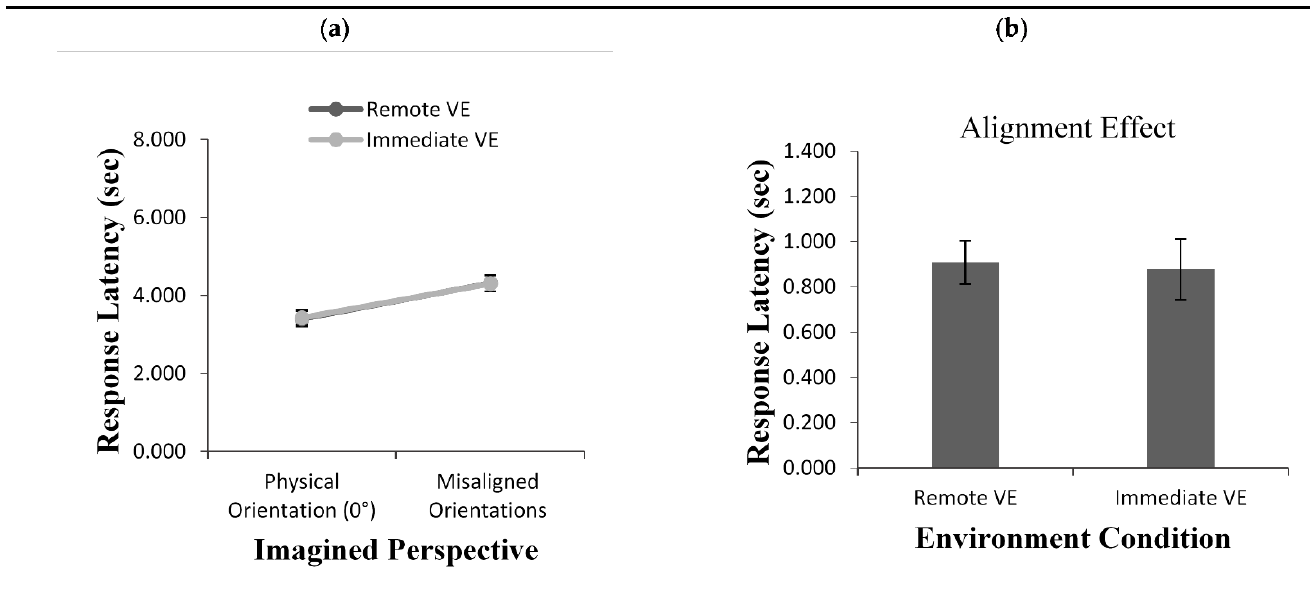
Figure 6. Response latency ( a ) as a function of imagined perspective and alignment effect for response latency ( b ) across test conditions (Remote VE vs. Immediate VE) in Experiment 1 and Experiment 2. Error bars represent standard errors from the ANOVA and from a t -test, respectively.